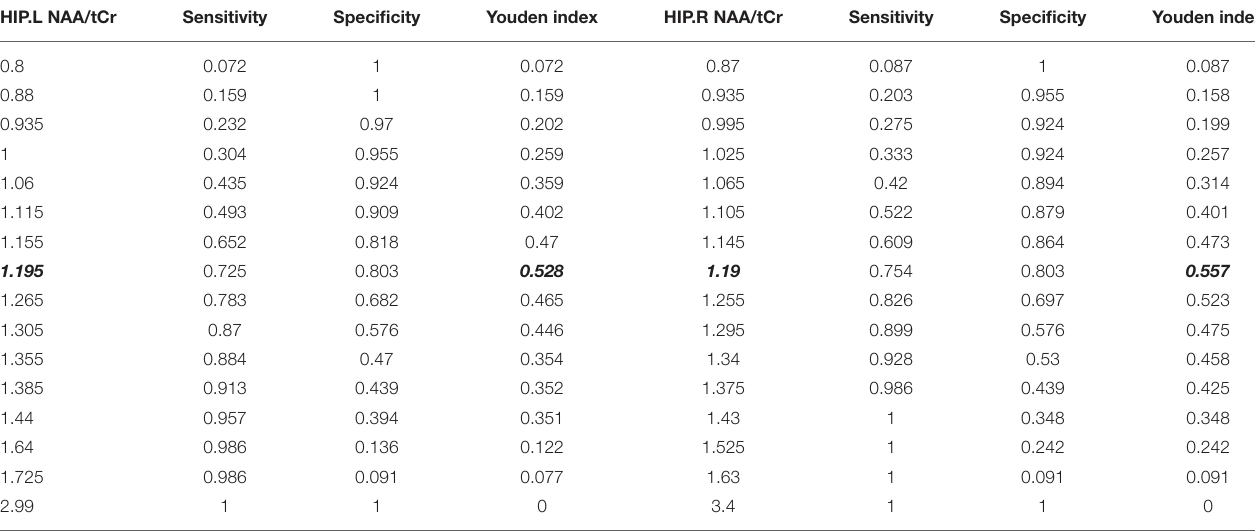
The bold and italics values represent the maximum Youden index value and the corresponding best cutoff value.